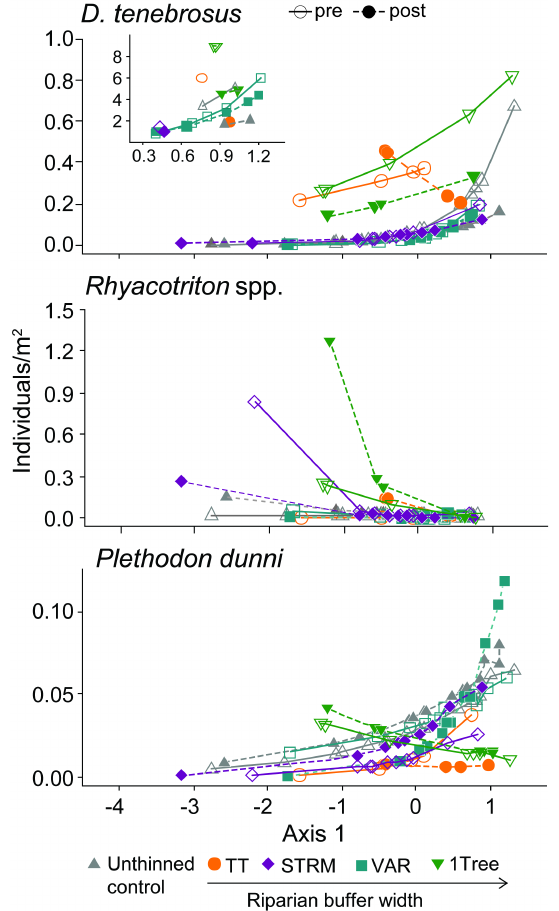
Figure 4. Estimates from generalized mixed model analysis of co-variance testing for the effects of riparian buffer treatments after a second moderate-density thinning treatment: 1Tree, variable (VAR), streamside (STRM), thin-through (TT) and year (pre-treatment = open symbols, solid lines; post-treatment = solid symbols, dashed lines) while controlling for habitat (non-metric multidimensional scaling (NMS) Axis 1) and sampling method (hand sampling vs. electrofishing); the inset for D. tenebrosus shows reaches sampled using electrofishing; where significant effects of the sampling method were not observed, methods were plotted